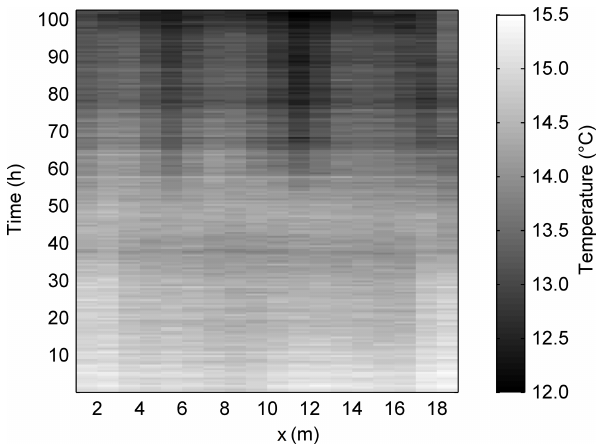
Figure 7. Temperature measured along the dike near the down- stream toe